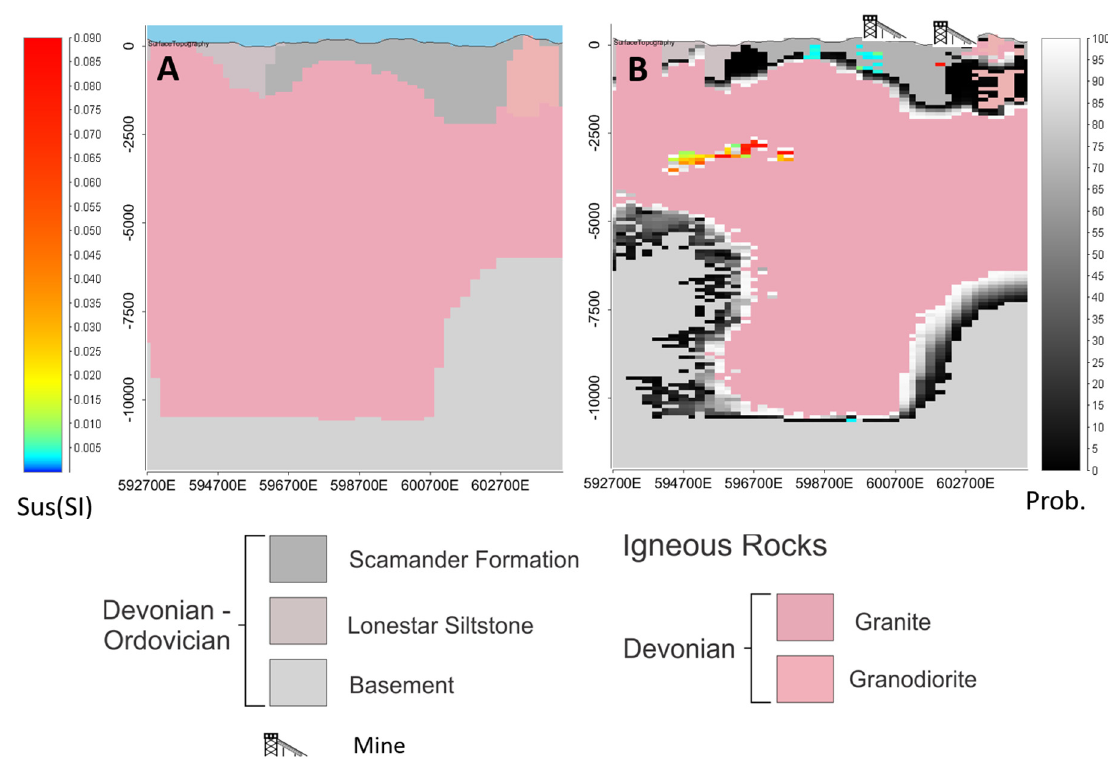
Figure 25. ( A ) East-west cross-section illustrating the reference starting model geology and intersecting the Great Pyramid Sn deposit at N 5413500. ( B ) illustrates the most probable threshold model geology and includes the probability of Devonian Granite and mean susceptibility informed by sensitivity modeling.